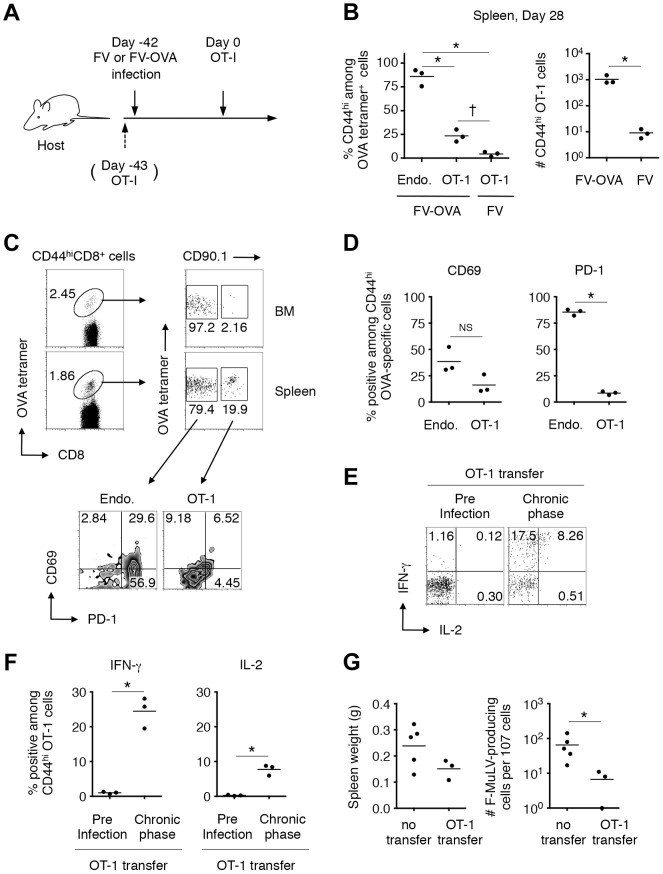
FV-specific CD8+ T cells can differentiate into functional memory CD8+ T cells if recruited during the chronic phase of infection.(A–D) B6AF1 mice were infected with either FV or FV-OVA. Six weeks later, FACS-sorted naïve (CD44lo) CD8+ T cells (1–2×107) from (OT-1-Thy1.1× A/WySnJ)F1 mice were transferred i.v. Splenocytes and BM cells were isolated at 28 days post transfer and stained with the indicated Abs and OVA257–264/Kb tetramer. (B) Percentages of CD44hi cells among OT-1 cells or endogenous OVA-specific CD8+ T cells, and actual numbers of CD44hi OT-1 cells recovered from FV-OVA- or FV-infected mice. Averages between groups in the left panel were compared by one-way ANOVA with Tukey's multiple comparison test: *, p<0.001; †, p<0.05. Averages between FV-OVA and FV groups were compared by Welch's t-test: *, p = 0.047. (C) Representative staining patterns for PD-1 and CD69 among OT-1 cells or endogenous OVA-specific CD8+ T cells in the BM and spleen. (D) Expression of CD69 and PD-1 on CD44hi OVA-specific CD8+ T cells in the spleen. Averages were compared for the two parameters between the endogenous and OT-1 cells: *, p<0.00001<α2 (0.05) = 0.0253 by student's t test with Bonferroni's correction for multiple comparisons. (E–F) A group of mice received 5×103 OT-1 cells 1 day prior to FV-OVA infection as a control for CD8+ T cell responses that were primed by initial infection. Splenocytes were stimulated in vitro with OVA257–264/Kb peptide. Shown are intracellular expression levels of IFN-γ and IL-2 of CD44hi OT-1 cells primed at the initial infection or during the chronic phase of infection. Averages were compared for the two parameters between the preinfection transfer and chronic phase groups: *, p = 0.012<α2 (0.05) = 0.0253 for IFN-γ and p = 0.013<α2 (0.05) = 0.0253 by Welch's t-test with Bonferroni's correction. (G) B6AF1 mice were infected with 5,000 focus-forming units of F-MuLV-OVA plus 2,000 SFFU of FV and naïve OT-1 cells (1×107) were transferred 28 days after infection. Four weeks after transfer of naïve OT-1 cells, spleen weights were measured, and splenocytes were cocultured with M. dunni cells to enumerate F-MuLV infectious centers. Each symbol represents an individual mouse. *, significantly smaller in the numbers of infectious centers in comparison with those in non-transferred mice; p = 0.0357 by Mann-Whitney test for non-Gaussian distributions.